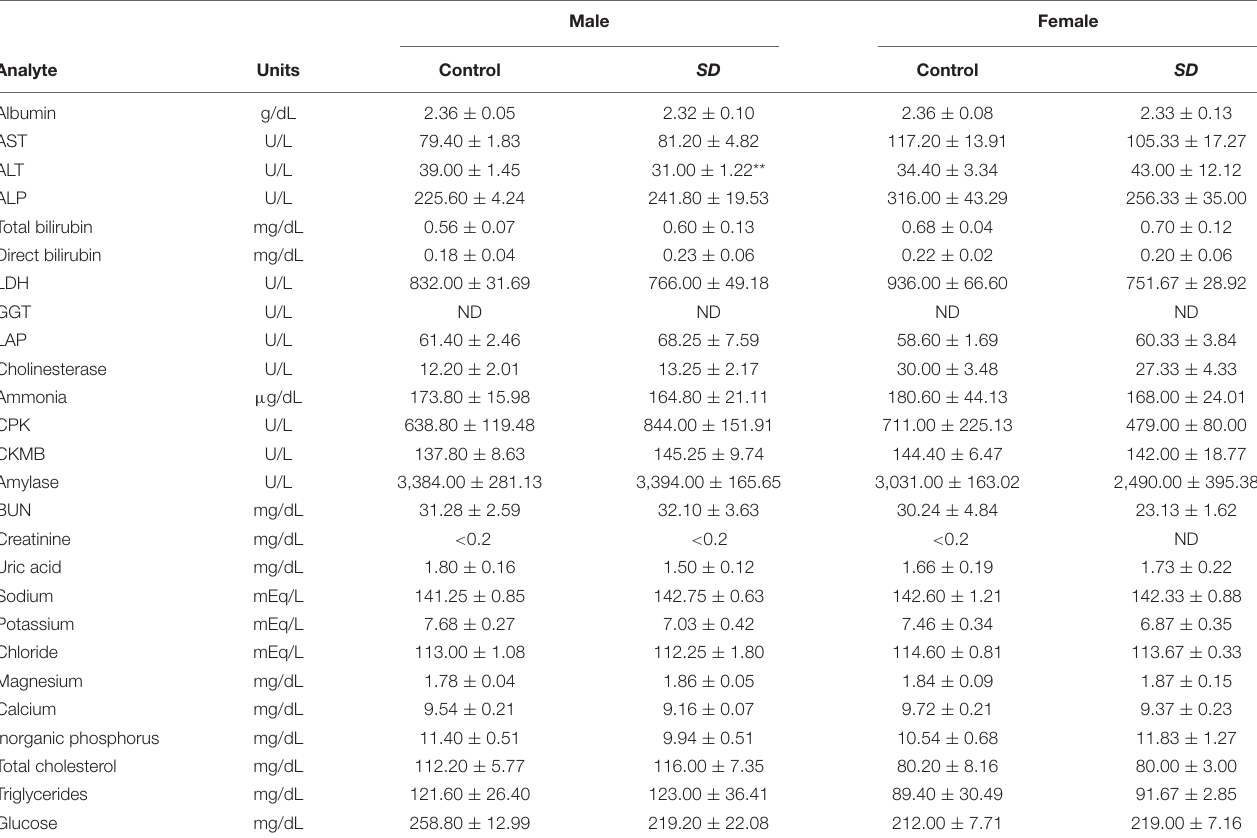
TABLE 5 | Test parameters of comprehensive clinical chemistry in mice after administration of mixed diet including 1% (w/w) NRG SD or 1% (w/w) base materials (control) for 28 days. Male